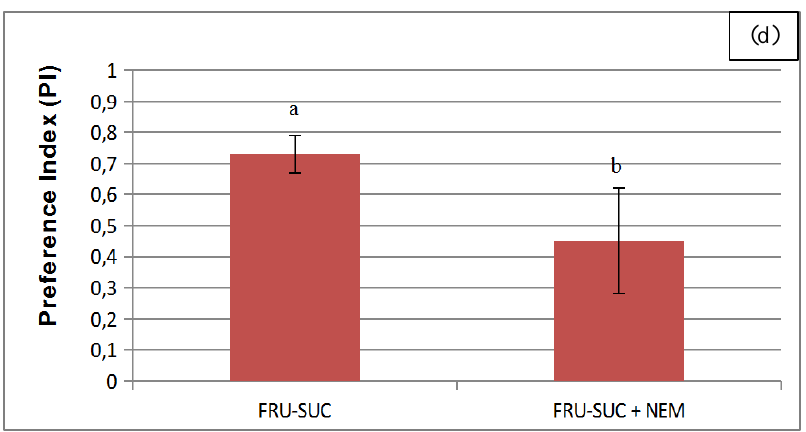
Figure 5. Feeding parameters and sugar preference of B. germanica after treatment with N-Ethylmaleimide (NEM). a) Latency; b) Number of visits to the food source; c) Weight gain; d) Preference Index (PI) for fructose vs sucrose. Marks and different letters indicate statistically significant differences among